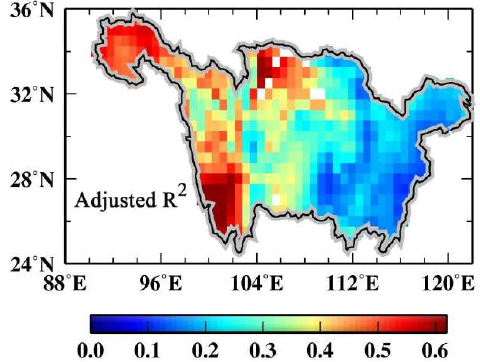
Figure 11. Coefficients of determination (R 2 ) of the MLR model between PM 2.5 and the six meteorological variables .